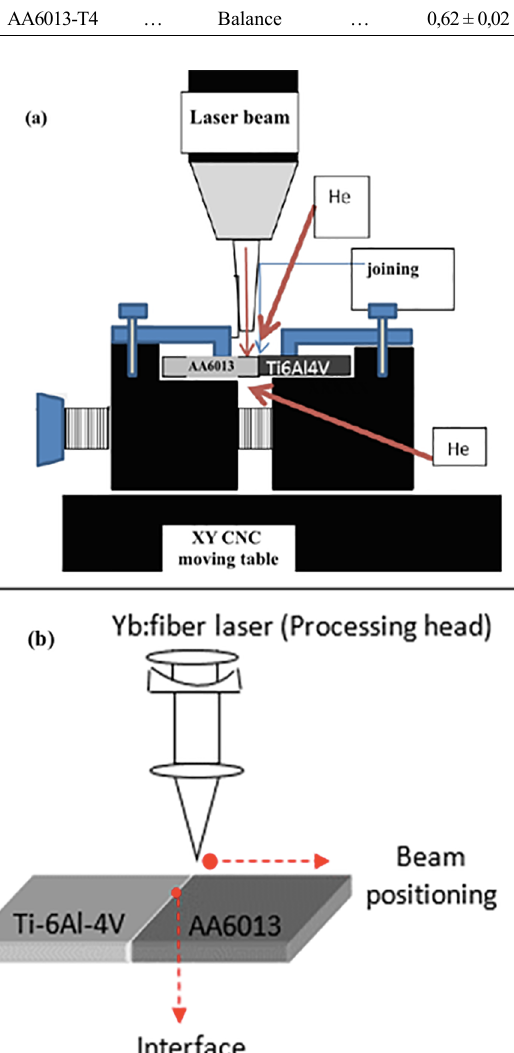
Figure 1. Schematic diagram of the joining experiment, showing (a) the laser joining system and (b) the variation of beam positioning along of interface joining toward Al alloy